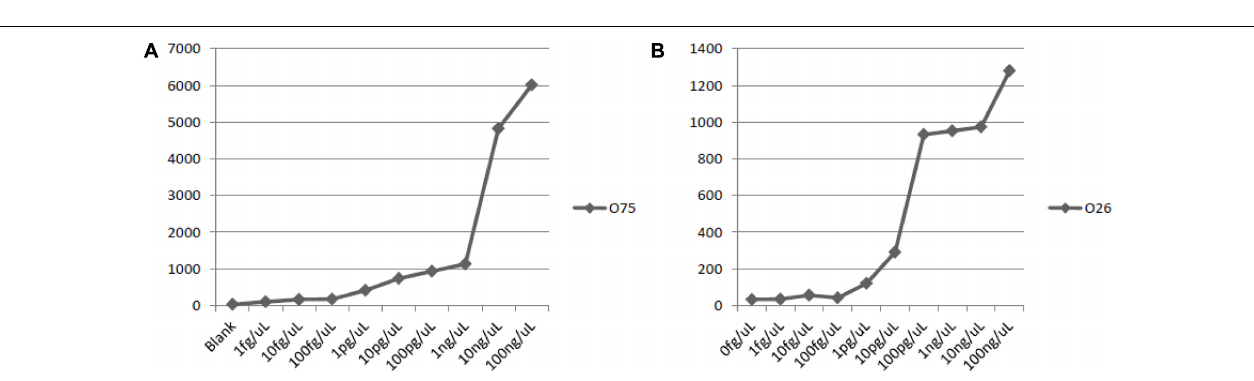
FIGURE 5 | Sensitivity of detection with genomic DNA of O75 and O26. (A) sensitivity of O75 genomic DNA; (B) sensitivity of O26 genomic